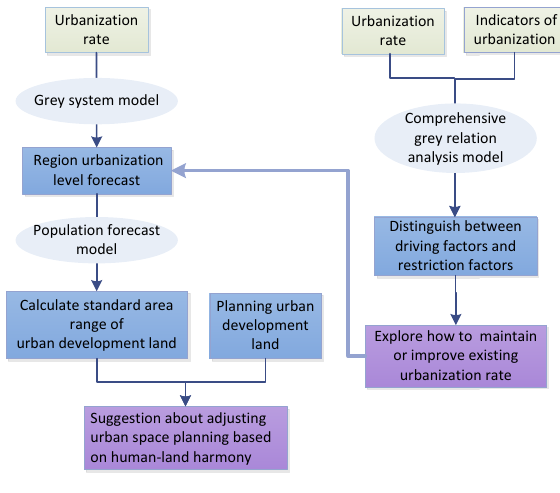
Figure1. Research